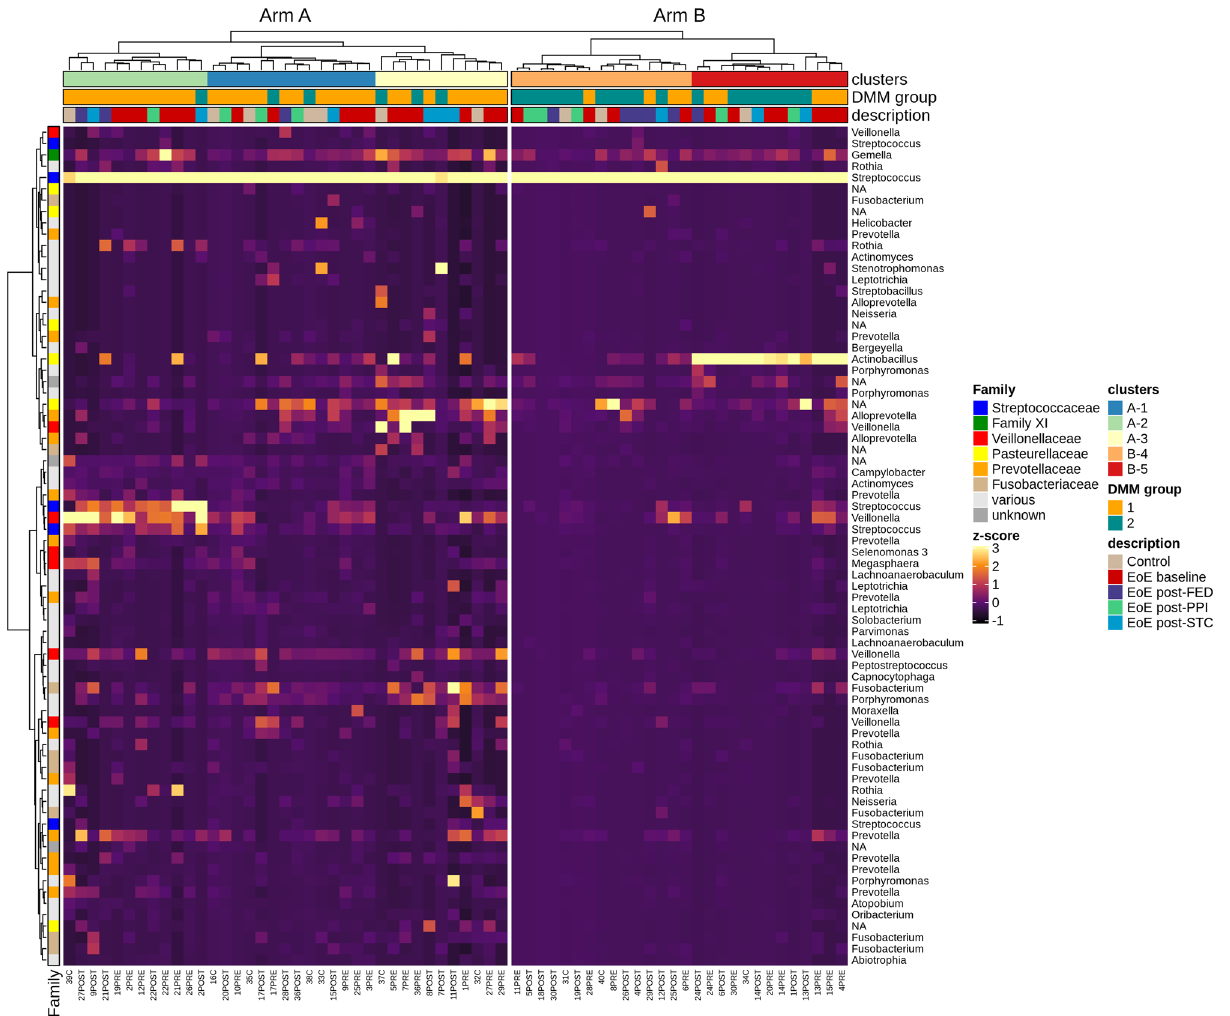
Figure 3. Heatmap and sample clustering. Z-score abundance heatmap with hierarchical Ward’s D2 linkage clustering based on Jaccard distances. The heatmap was created as a subset of features (74 out of 1004) with abundances above 800 reads. Colour codes were added to identify samples according to disease/treatment conditions, hierarchical cluster, and Dirichlet multinomial mixture (DMM) groups as defined in Fig.